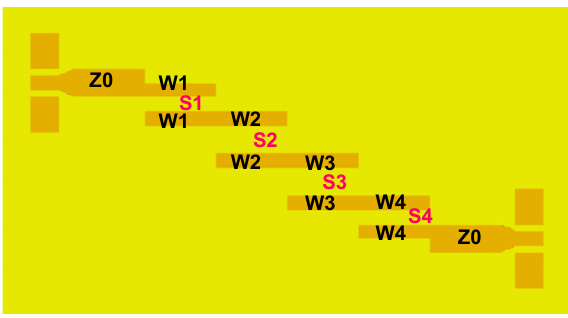
Figure 2. Typical parallel-coupled bandpass filter.